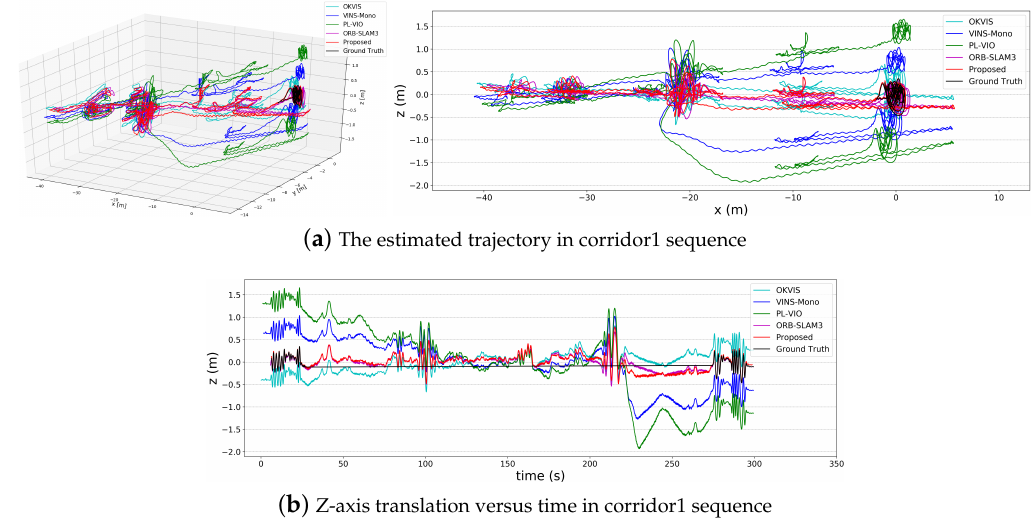
Figure 10. The performance of each system in the corridor1 sequence is shown in the figure. We give the estimated trajectory and side view of each system after alignment, and we give the curve of Z-axis translation versus